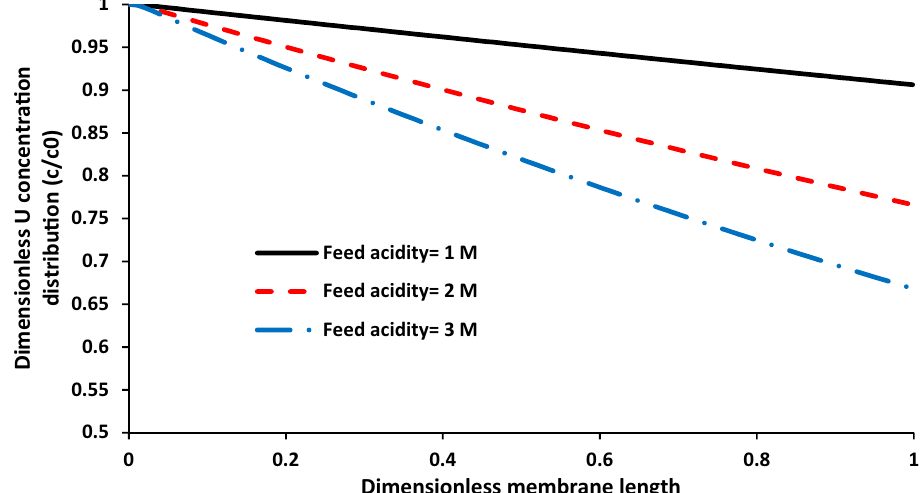
Figure 7. Dimensionless uranium concentration distribution along membrane contactor at different feed